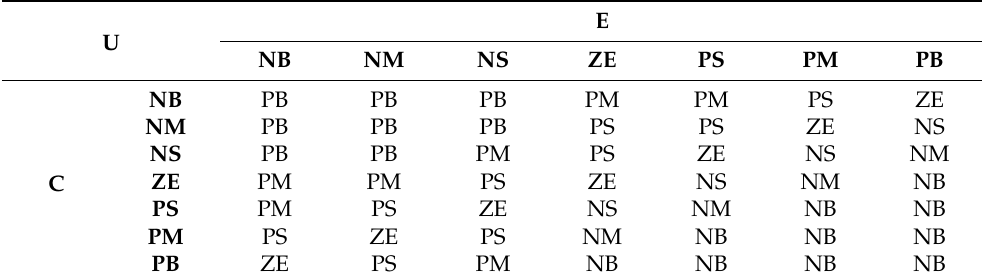
Figure 4. Triangle type membership function diagram. Since the load force, change rate of the load force, and the output speed of electro-hydraulic servo pump control system are accurate quantities, and the control parameters in the fuzzy controller are fuzzy quantities, the range of variables [a, b] needs to be transformed into the domain [ − 6, 6], and each interval corresponds to different fuzzy sets. In this system, the range of load force is below 12 KN, and the domain of load force input variable is [ − 6, 6], so the quantization factor of load force input is 0.001; the range of load force change rate is [ − 60, 60], and the domain of input variable of load force change rate is [ − 6, 6], so the quantization factor of input quantity of load force change rate is 0.1; the range of output speed is [ − 300, 300], and the domain of output speed variable is [ − 6, 6], so the scale factor of output speed variable is 50. Fuzzy control rules for the load disturbance force were established in accordance with relevant theories, as shown in Table 1. Table 1. Fuzzy control rule statement